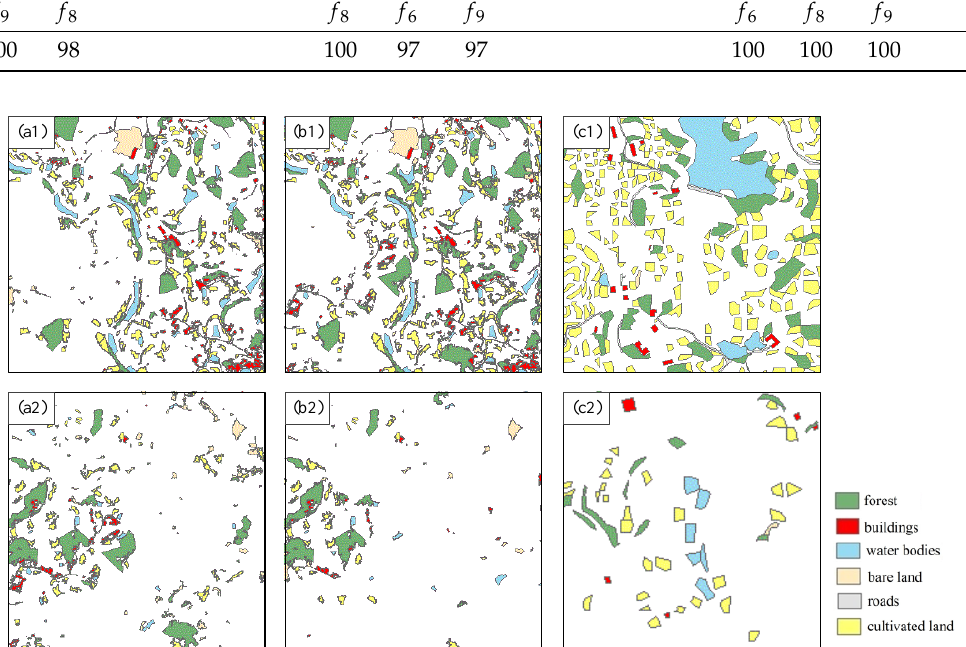
Figure 8. The results of outlier sample detection. ( a1 , a2 ) are the results of samples and outlier samples in experiment one, respectively; ( b1 , b2 ) are the results of samples and outlier samples in experiment two, respectively; ( c1 , c2 ) are the results of samples and outlier samples in experiment three, respectively. Table 3. The results of texture feature selection for six types of surface objects in the three experiments.